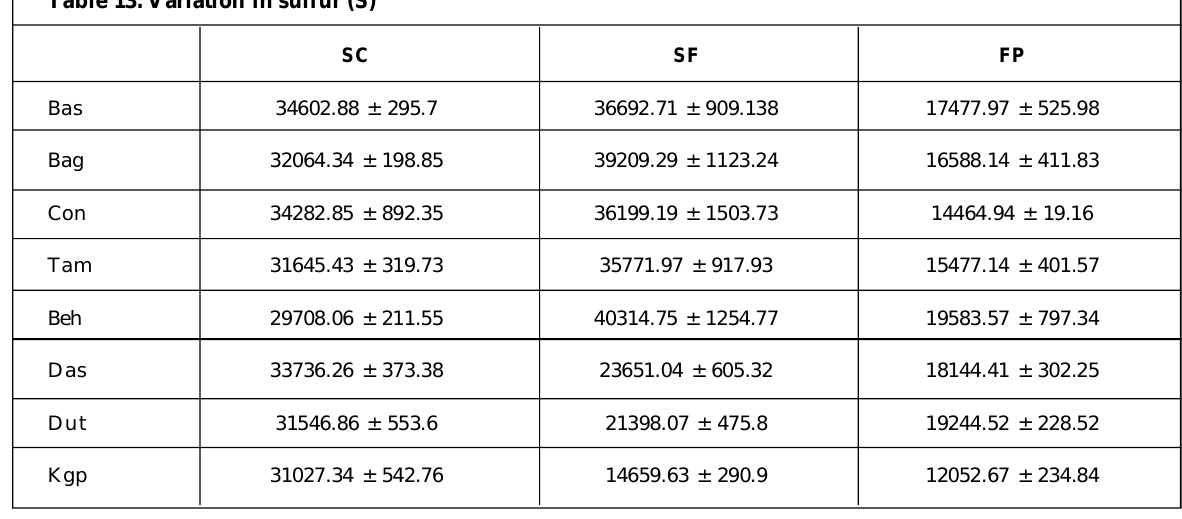
Table 13: Variation in sulfur (S)